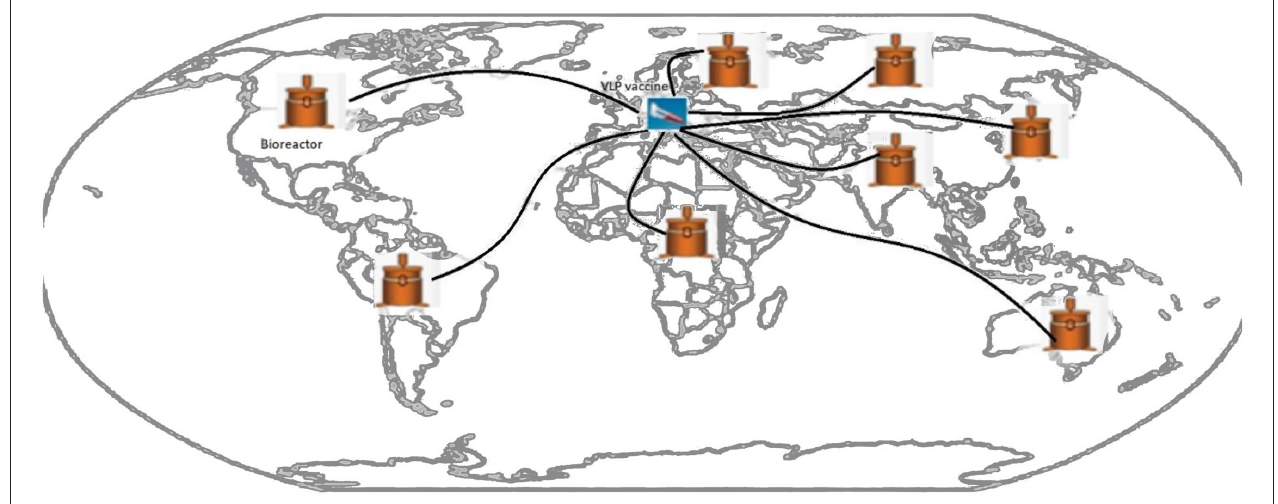
FIGURE 1 | The possible satellite WHO-supervised distributions sites of the preemptive VLP vaccine during COVID-19